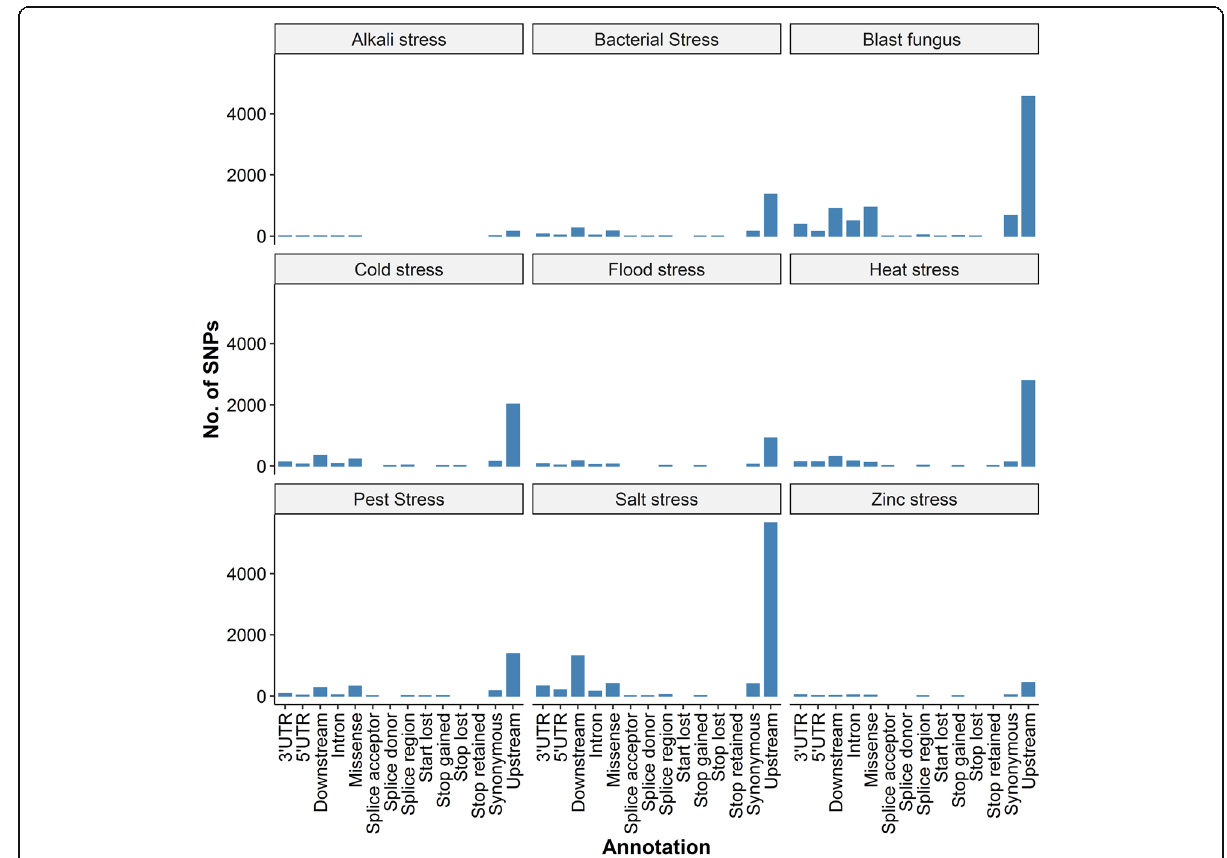
Fig. 5 The alternate allelic frequency distribution in different abiotic and biotic stress-resistant genes in rice. The X axis represents the allele frequencies of the non-reference alleles and the Y axis represents of the count of each allele frequency of the SNPs in these